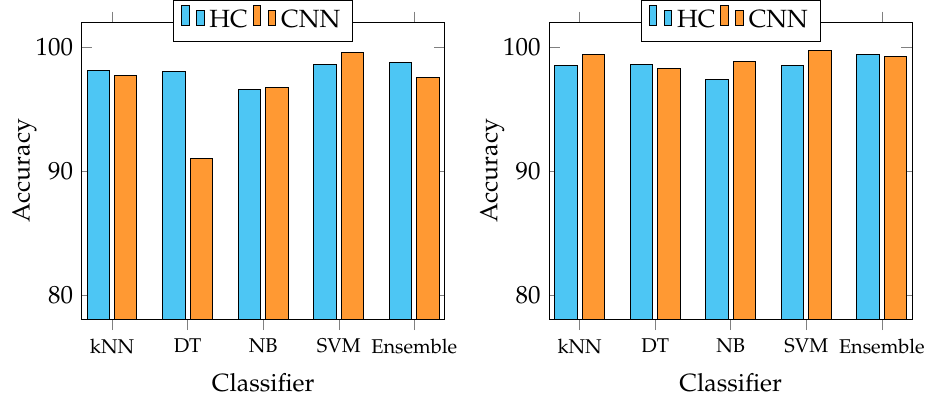
Figure 3. Accuracy trends with the different classifiers adopted. On the left, best accuracies obtained on Canada data set; on the right, on Cagliari data